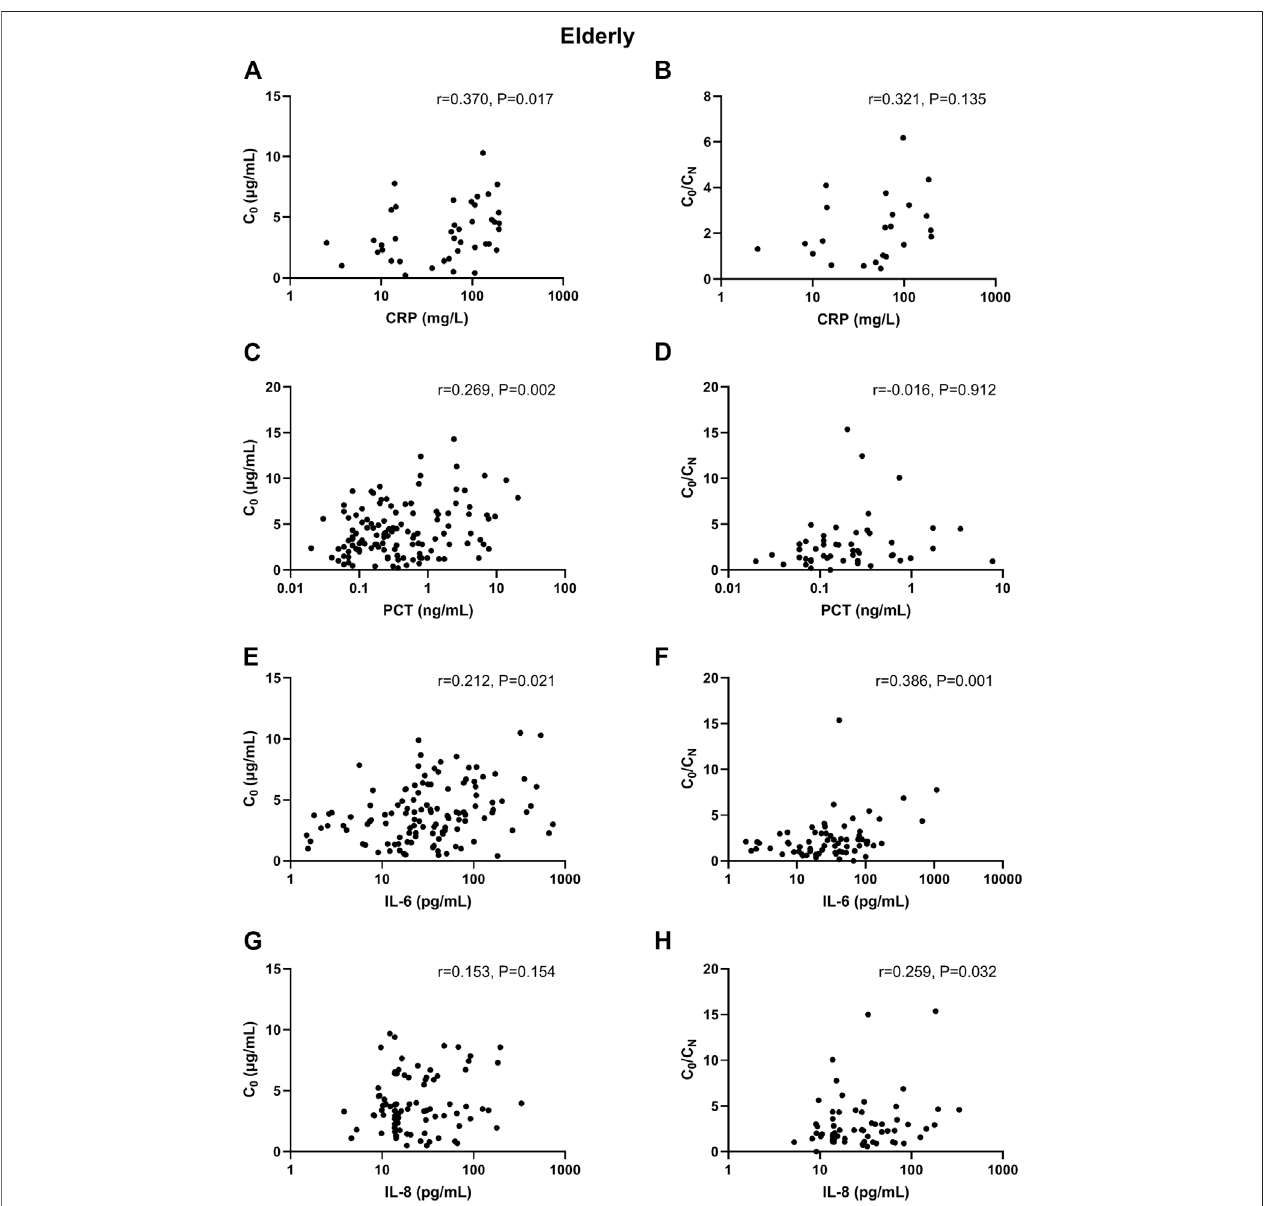
FIGURE 2 | Association of CRP, PCT, IL-6, and IL-8 plasma levels with VCZ C 0 and VCZ C 0 /C N ratio in elderly patients. (A,B) The CRP levels were moderately associated with VCZ C 0 but not associated with VCZ C 0 /C N ratio. (C,D) The PCT levels were poorly associated with VCZ C 0 but not associated with VCZ C 0/ C N ratio. (E,F) The IL-6 levels werepoorlyassociatedwith VCZ C 0 but moderately associated withVCZ C 0 /C N ratio. (G,H) The IL-8levels werenot positively associatedwith VCZ C 0 but were poorly associated VCZ C 0 /C N